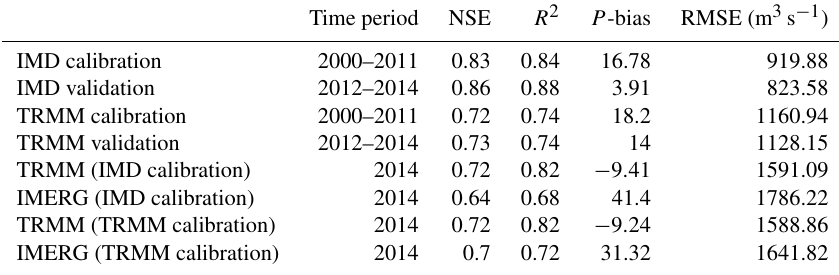
Table 8. Performance statistics for rainfall-runoff modeling using VIC for Wainganga River basin.